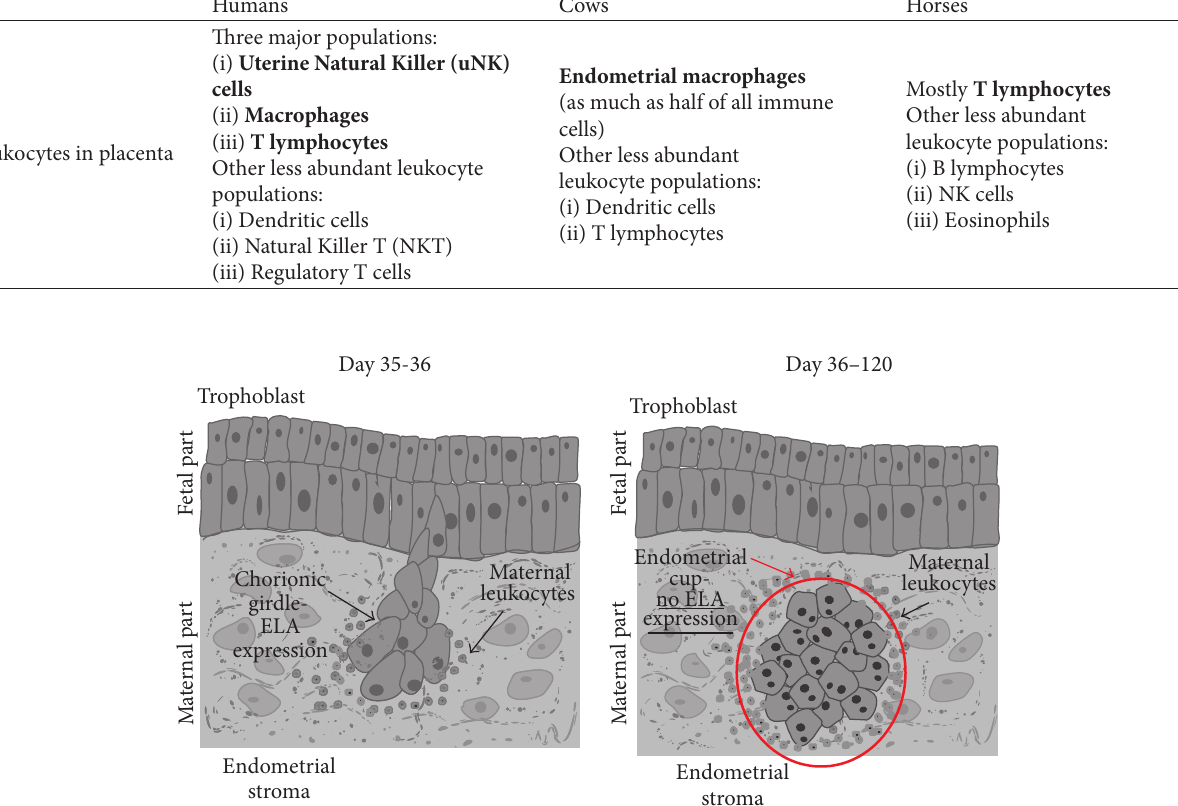
Table 2: Leukocytes that have been found in the placenta during physiological pregnancy in humans, cows, and horses [29–33]. Humans Cows Horses